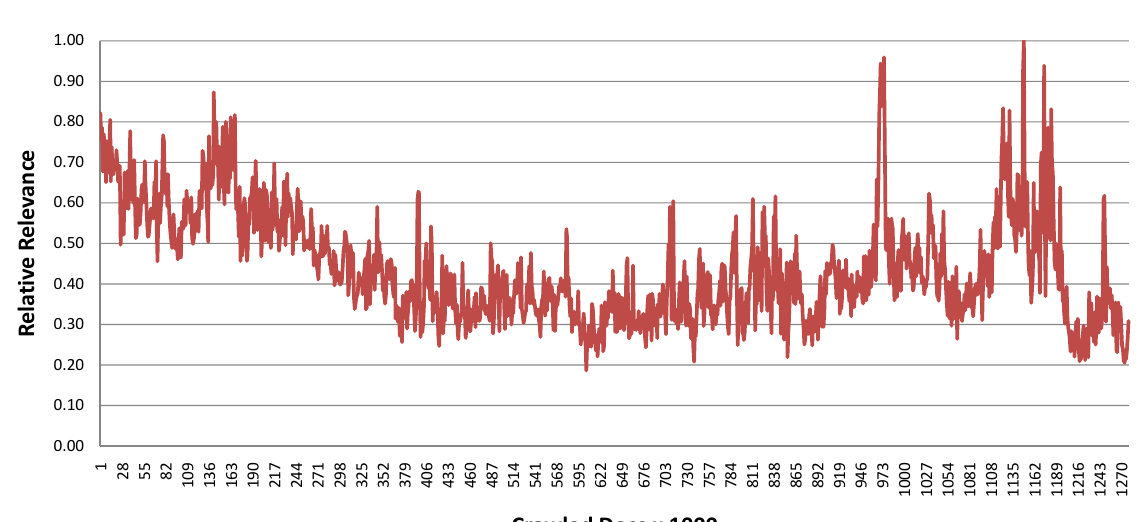
Figure 9. Twitter based crawl over